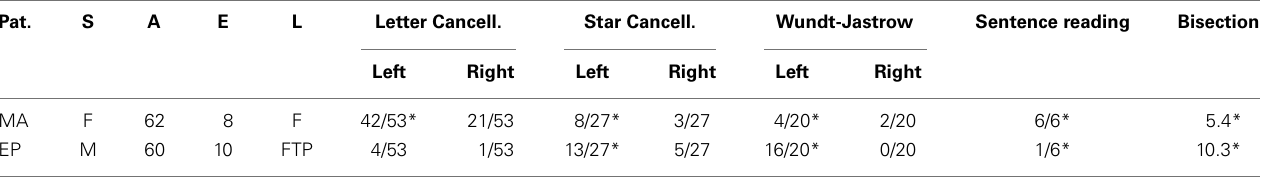
F, frontal lobe; P, parietal lobe;T, temporal lobe; S, sex; M/F, male/female; A, age; E, educational level; L, lesion location; Scores: (i) cancelation tasks: omission errors; (ii) Wundt-Jastrow area illusion test: “unexpected” responses; (iii) reading task: the number of sentences in which patients showed left-sided errors; 16cm lines bisection error (mm). *Pathological score; L, left; R,